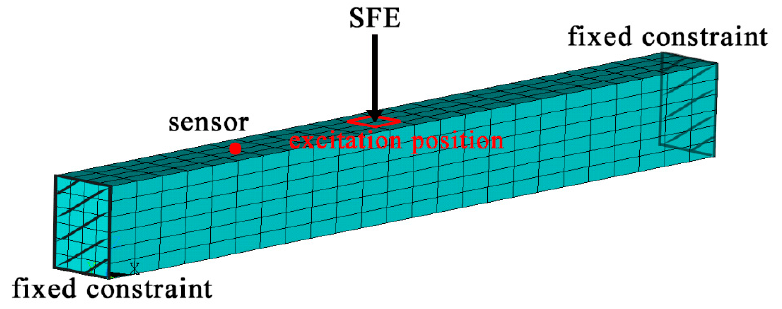
Figure 2. Finite element model of a two-end fixed beam.